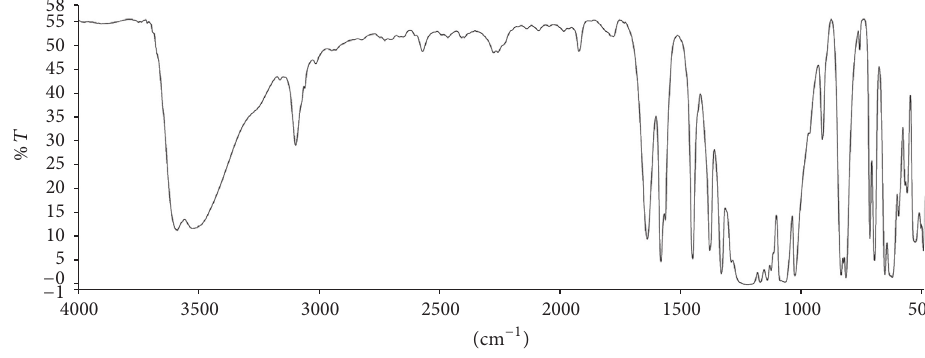
Figure 1: FTIR spectrum of SDCDPS.